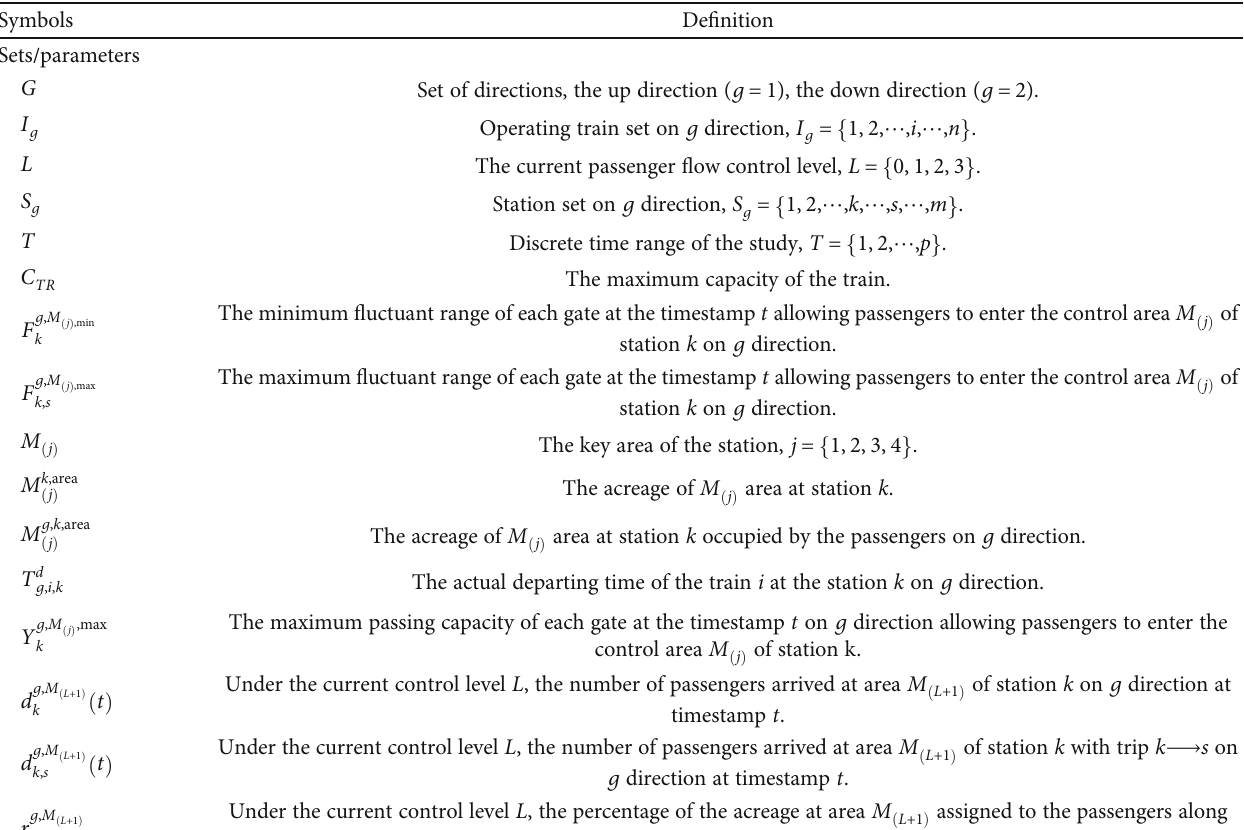
Table 1: The symbols involved in the